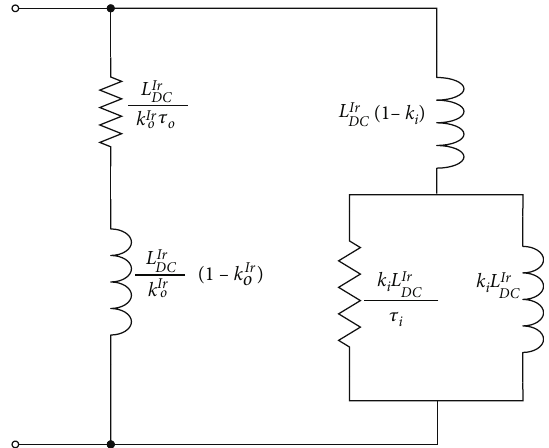
Figure 8: Approximate circuit model for a lossy superconducting magnet: inner and outer conducting shells with an iron